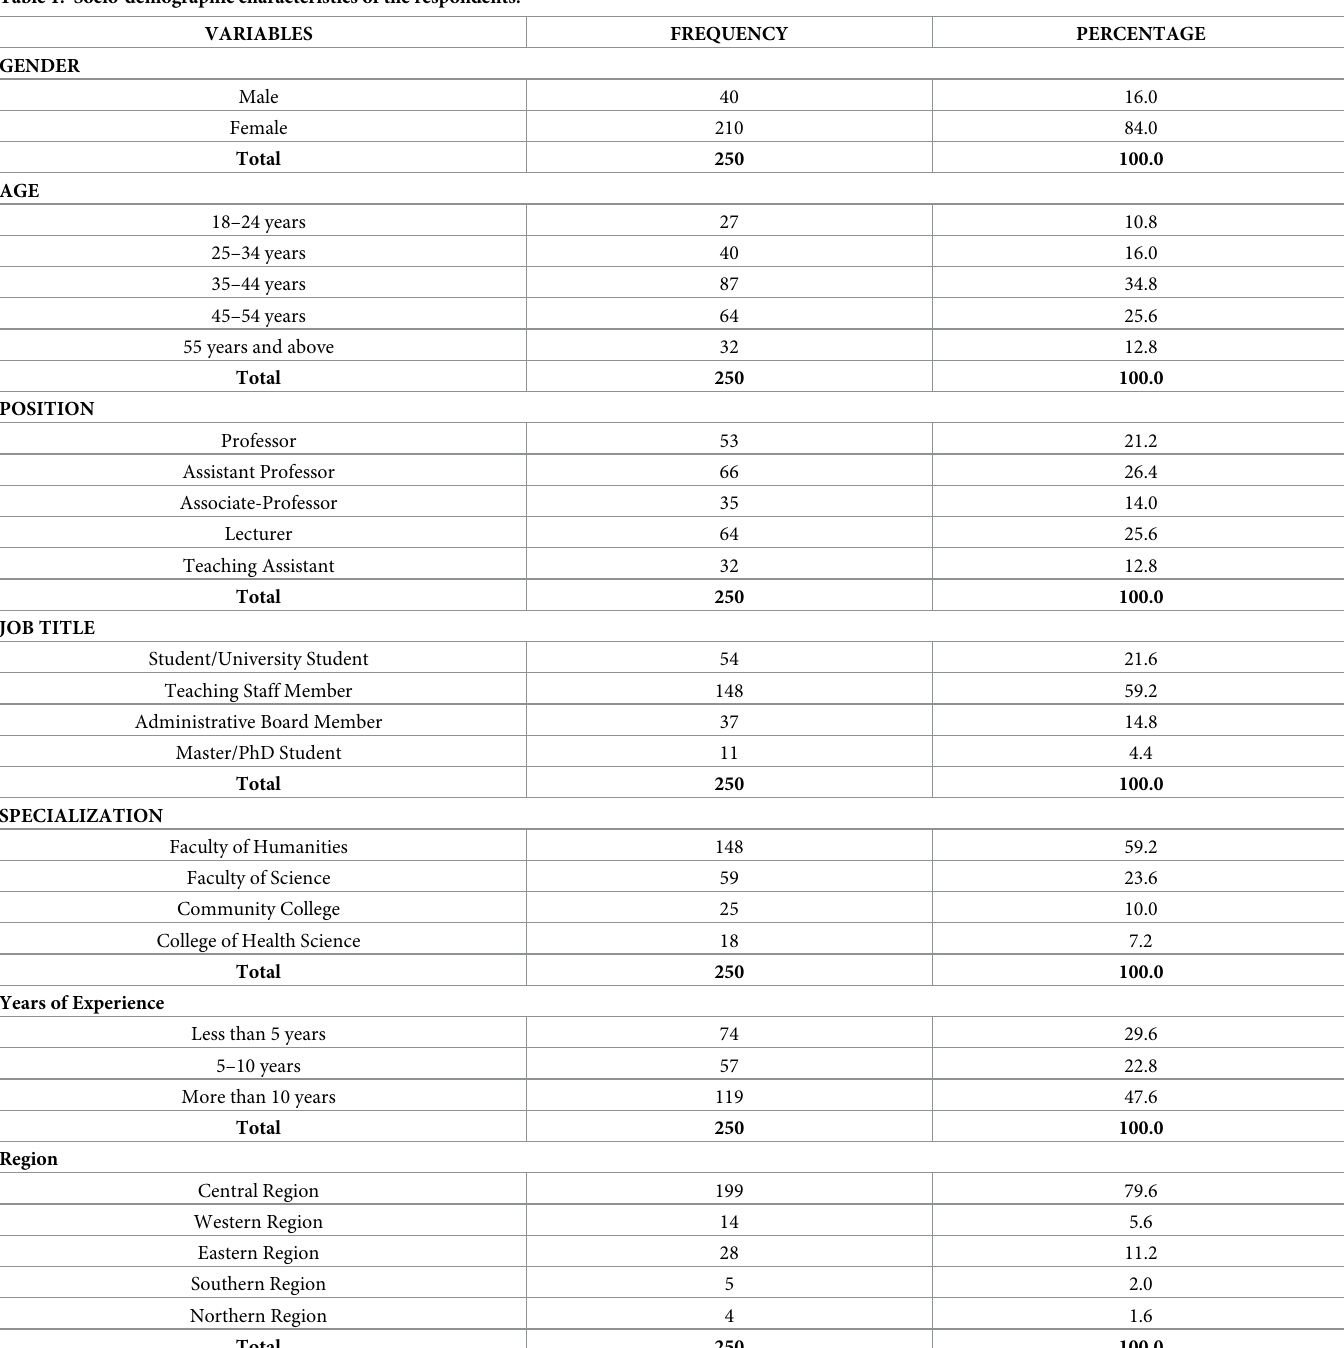
Table 1. Socio-demographic characteristics of the